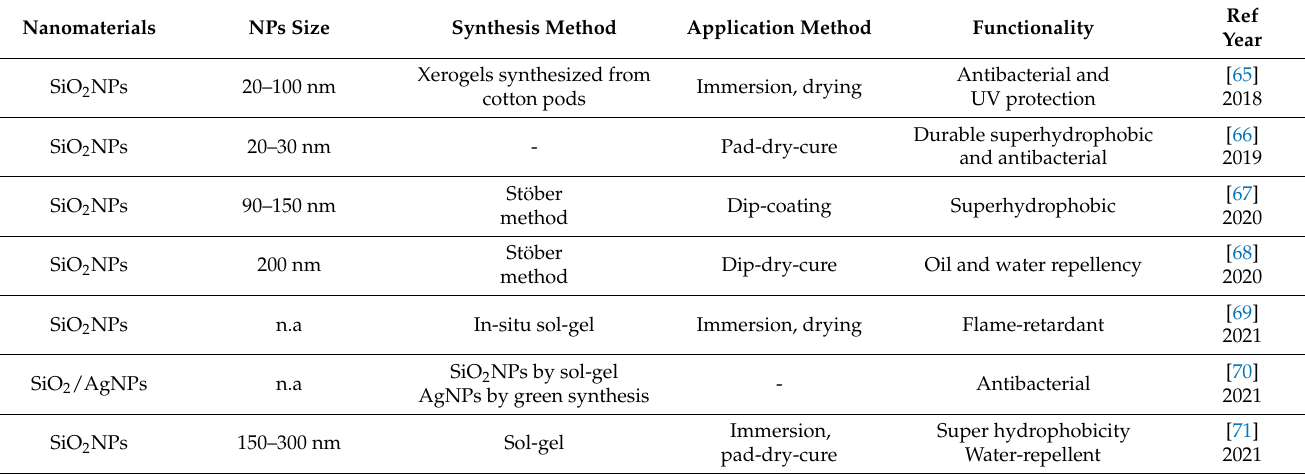
Table 3. A survey of the functionalization of cotton fabrics with SiO 2